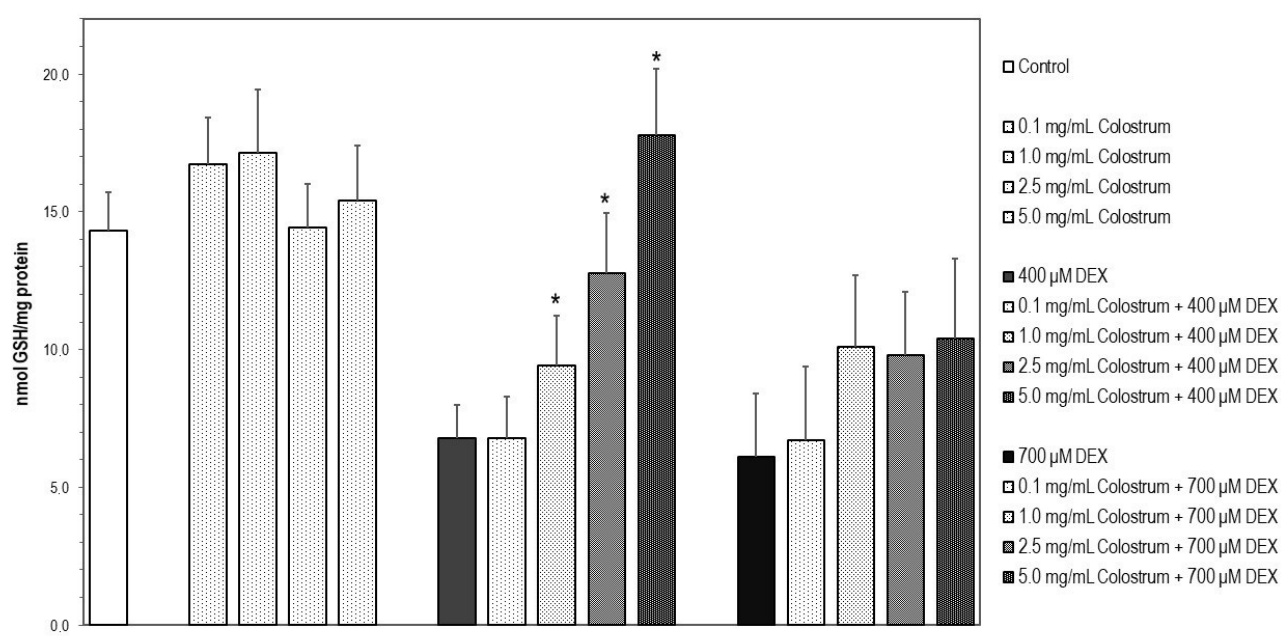
Figure 9. Colostrum treatment restores GSH levels in DEX-treated MC3T3-E1 cells. Reduced glutathione (GSH) was determined spectrofluorometrically [36]. Cells were treated with quercetin or rutin for 24 h. The concentration of GSH in each sample was interpolated from known GSH standards. Fluorescence was measured at λ exc = 350 nm (bandwidth 5 nm) and λ em = 420 nm (bandwidth 5 nm). Protein was measured by the bicinchoninic acid method. Values were expressed as nmol/mg of protein. * Significant differences of colostrum plus 400 µ M DEX versus 400 µ M DEX-treated cells (Newman–Keuls test, * p <